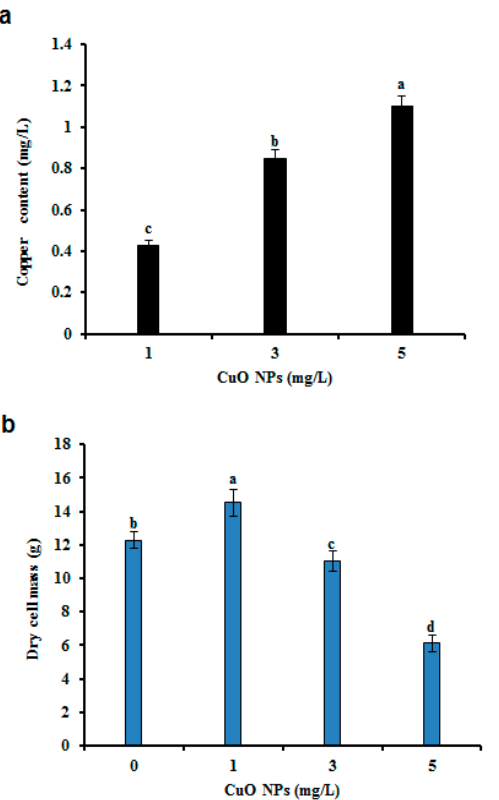
Figure 2. Effect of copper oxide nanoparticles (CuO NPs) on copper content and biomass accumulation in cell suspension cultures (CSC) of G. sylvestre . ( a ) Copper content, ( b ) biomass accumulation. Different letters indicate a significant difference at p ≤ 0.05.